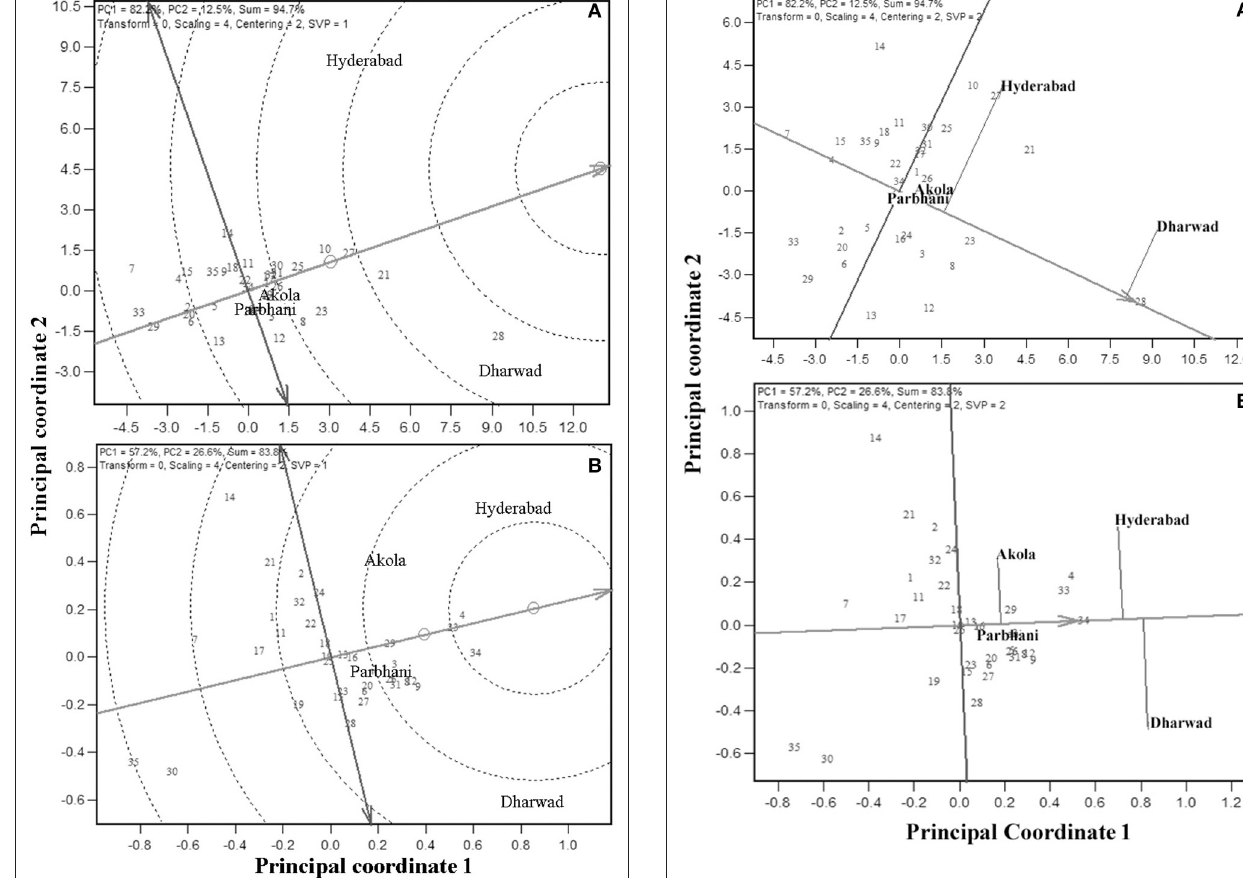
FIGURE 4 | Ranking of four environments based on the performance of the highest yielding genotype, 28 for GY (A) and most resistant genotype, 34 for grain mold score (B)